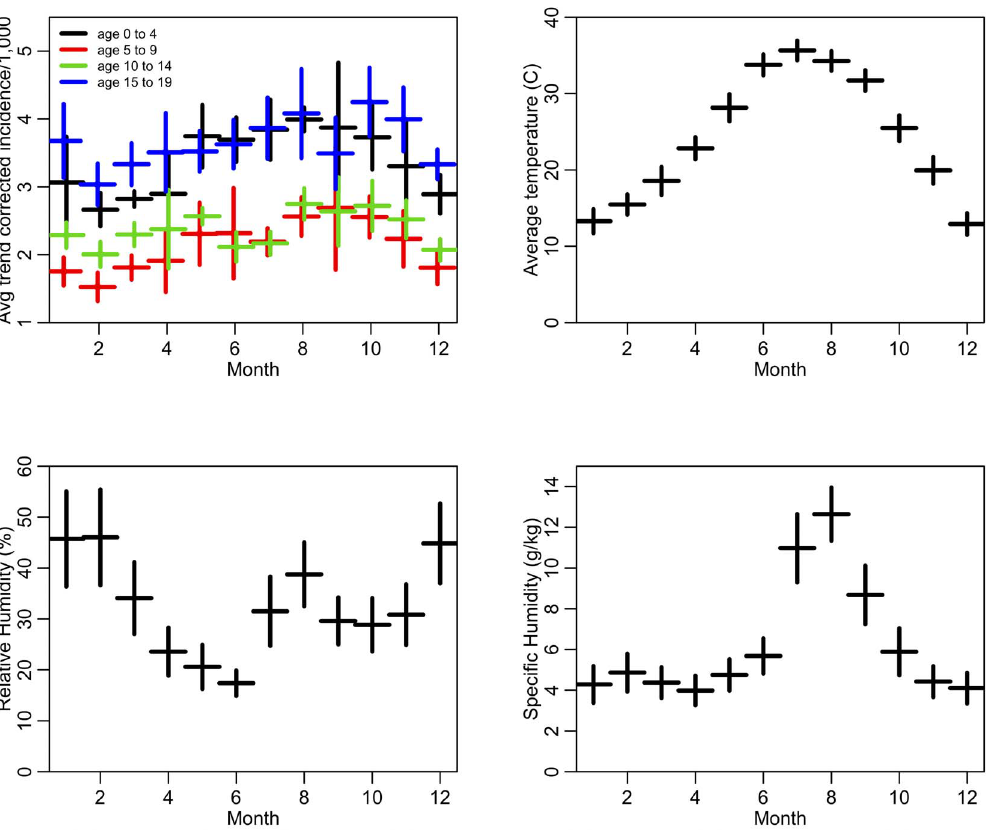
Figure 4. The first plot shows the within-month average of the trend-correlated incidence of SSTIs for each of the four pediatric age groups. The vertical error bars represent the one standard deviation error on the mean. The trend corrected incidence is the incidence minus the trend term in the regression model ( at z b in Equation (1)). The second to fourth plots show the within-month average of temperature, relative humidity, and specific humidity, respectively.